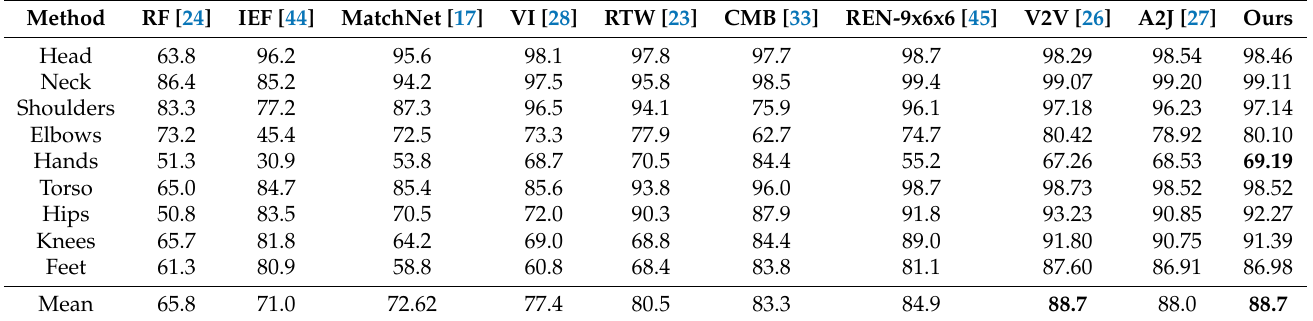
Table 1. Performance comparison on the ITOP front-view dataset. We evaluate the methods that use the metric of the mean average precision (mAP) with the 10-cm rule. We show the results of each human joint and the average results of all the human joints.